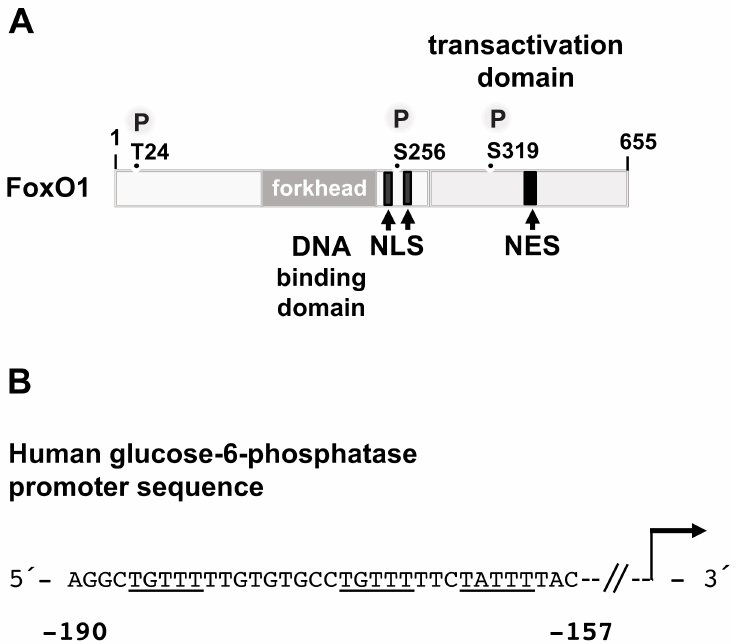
Figure 7. Modular structure and binding sites of FoxO1. ( A ) FoxO1 contains a DNA binding domain (forkhead) and a C-terminal transactivation domain. Nuclear localization signals (NLS), nuclear export signals (NES), and phosphorylation sites (P) are depicted. ( B ) FoxO1 binding sites within the human glucose-6-phosphatase gene promoter. The binding motifs are underlined. The sequence was obtained from GeneBank